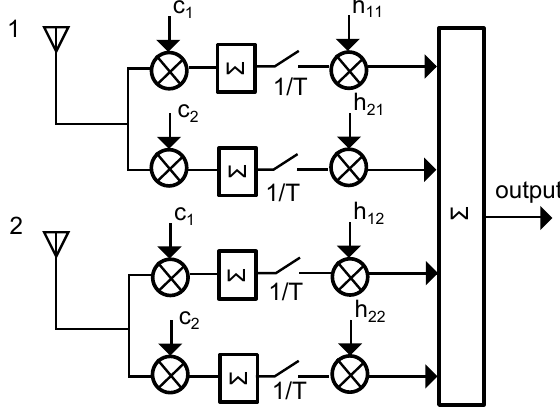
Figure 1. Schematic of a receiver with maximal ratio combining diversity for two input